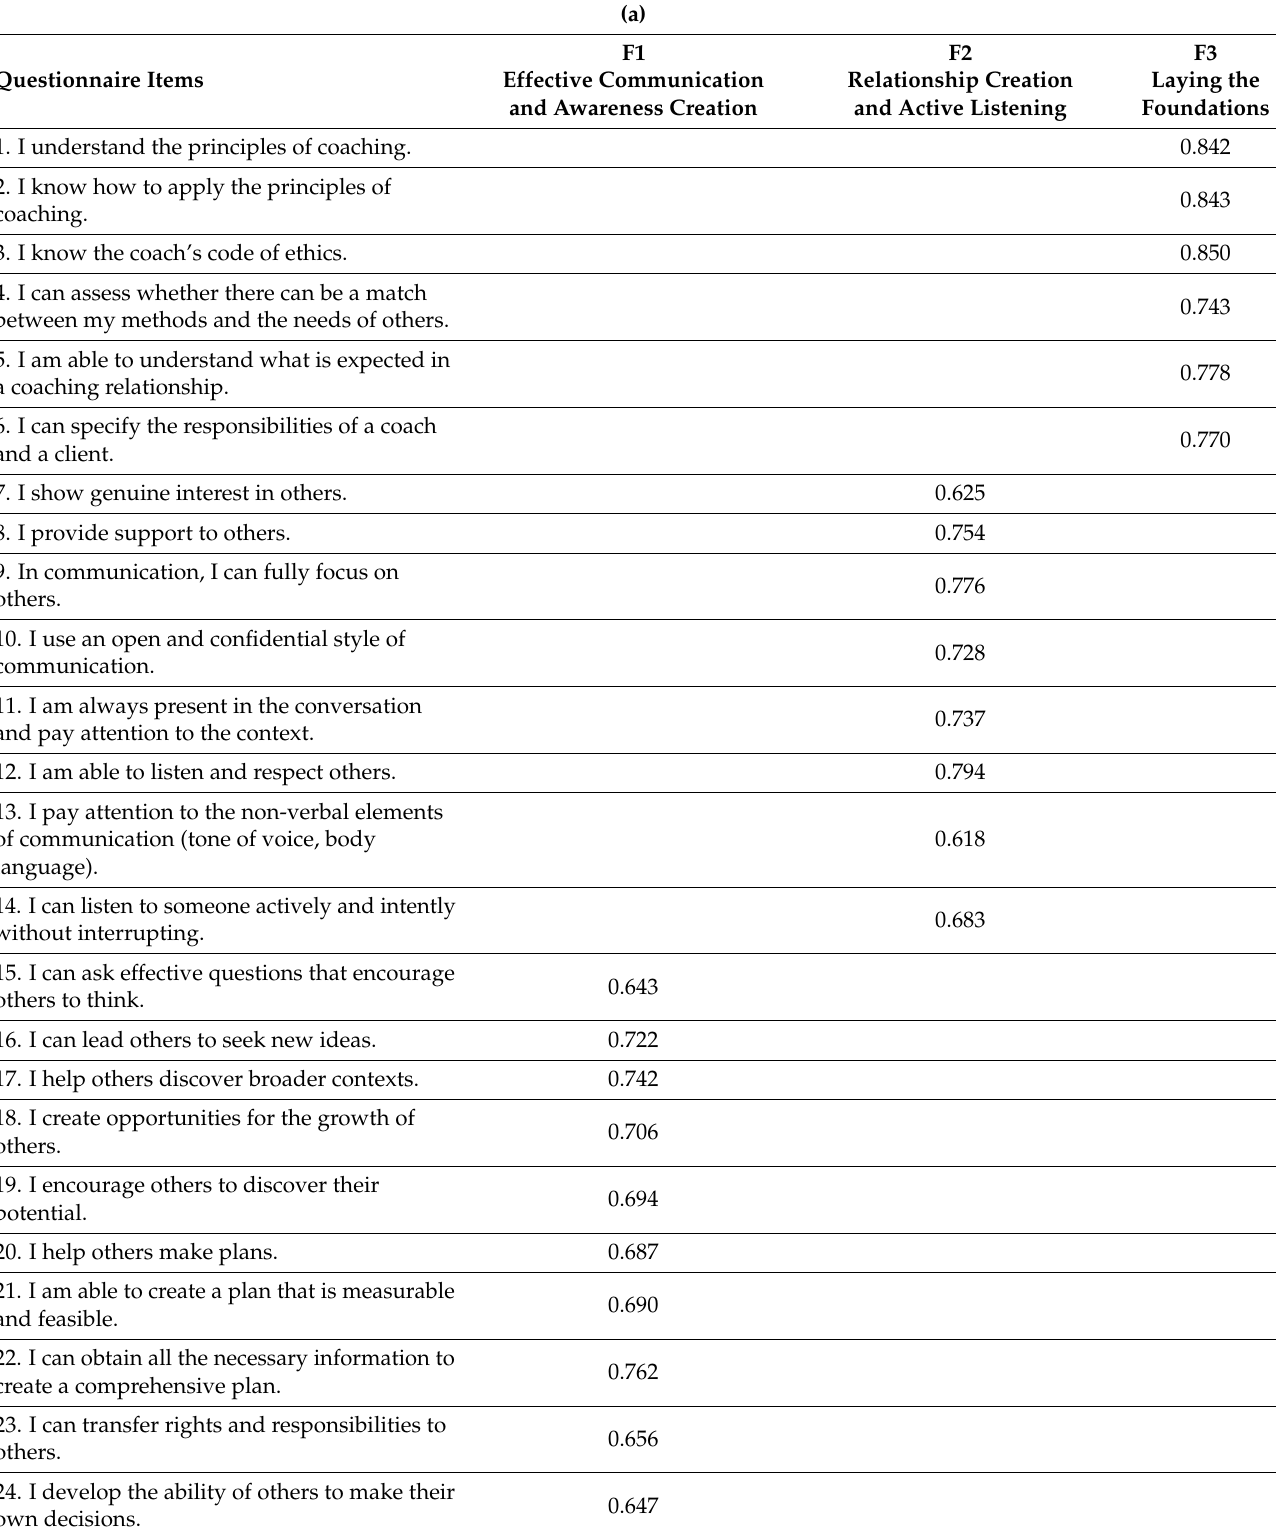
F2—relationship creation and active listening, and F3—laying the foundations (Figure